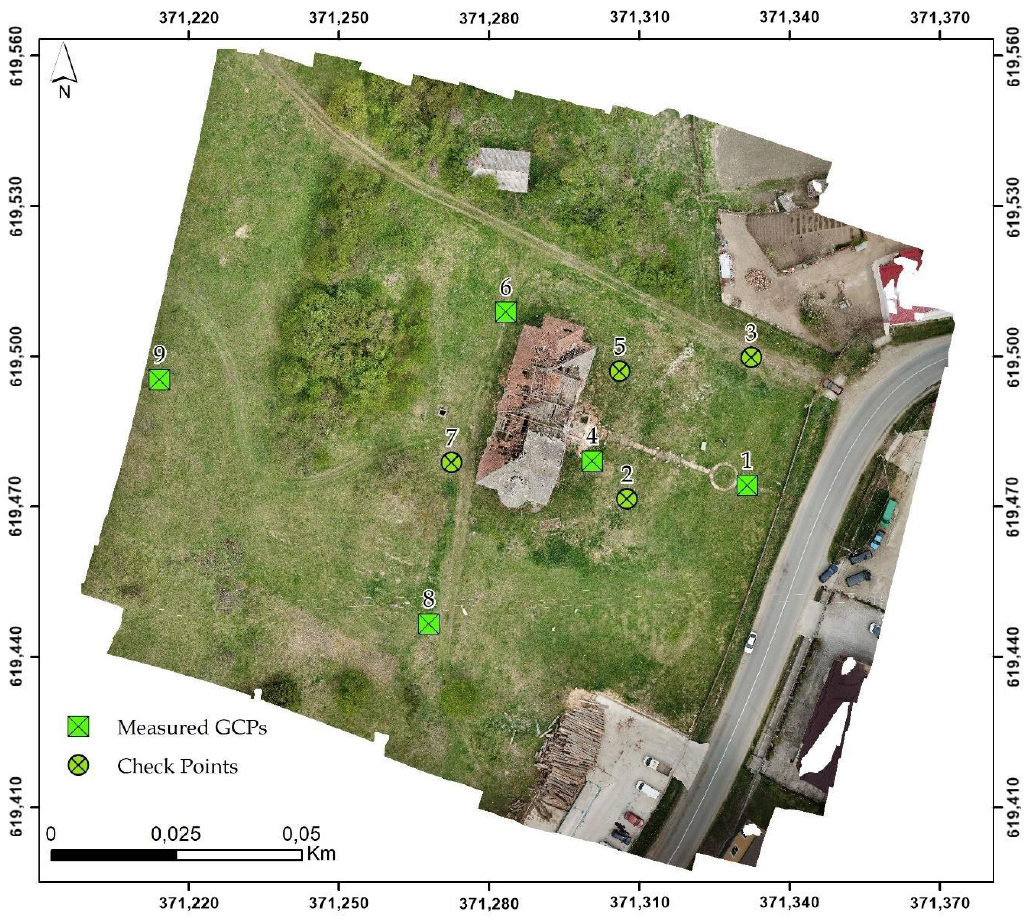
Figure 10. Obtained orthophoto.